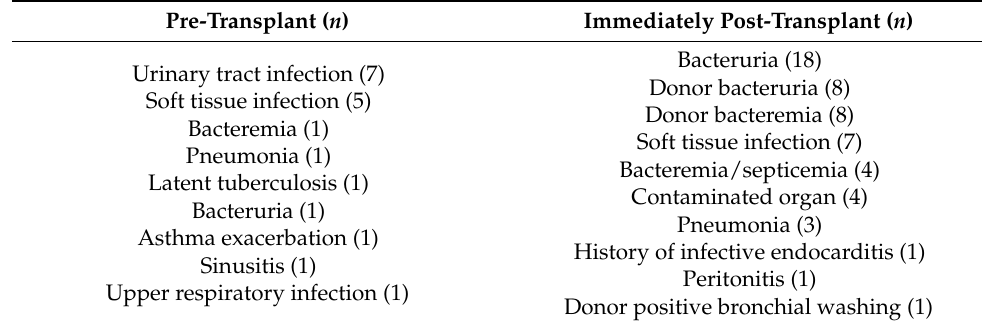
Table 2. Indications for the use of broad-spectrum antibiotics.